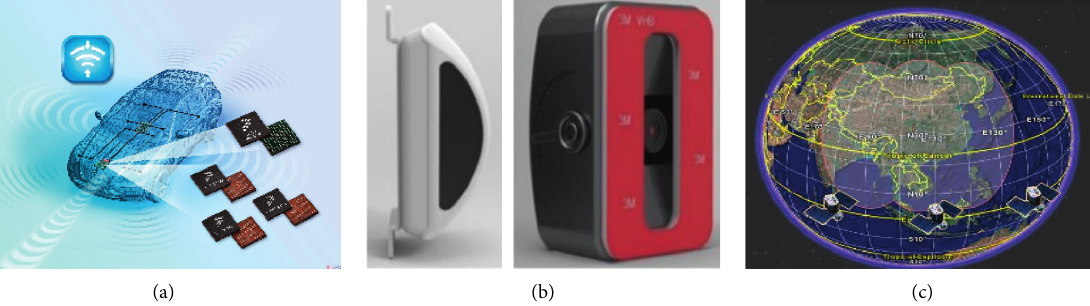
Figure 1: Forewarning equipment of buses: (a) ADAS yaw forewarning system; (b) fatigue driving analysis equipment; (c) BDS.